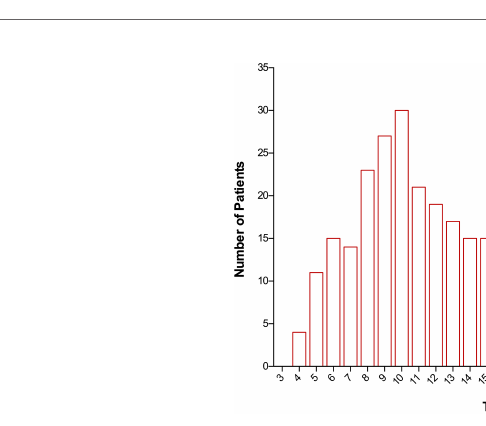
Figure 3B ) and 5-year RFS (66.6% or 73.4%, vs. 82.2%, P-